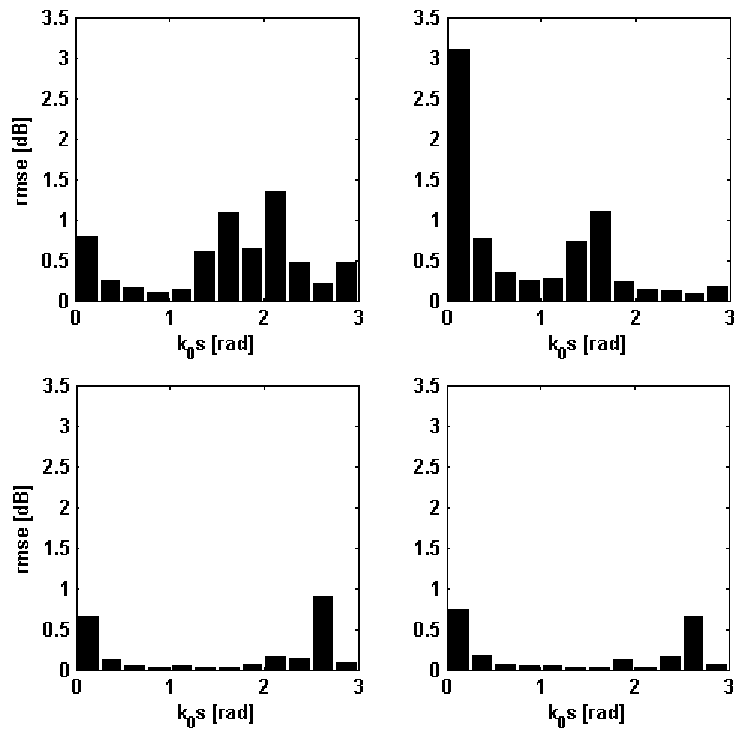
Figure 3. Trend of the rmse (error bars) versus k panels: horizontal polarization. Upper panels: L-band; lower panels: